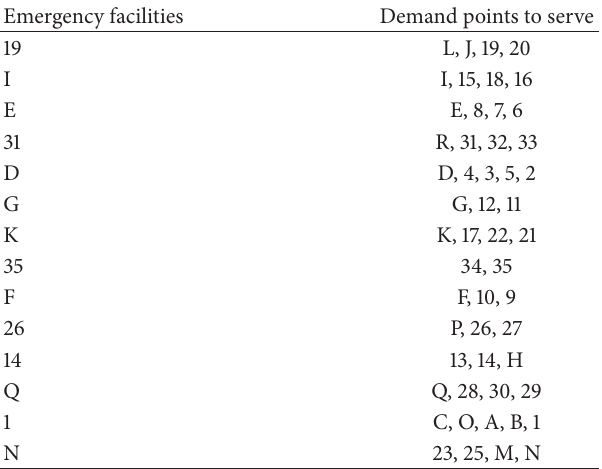
Table 4: The emergency facilities and the demand points they serve. Emergency